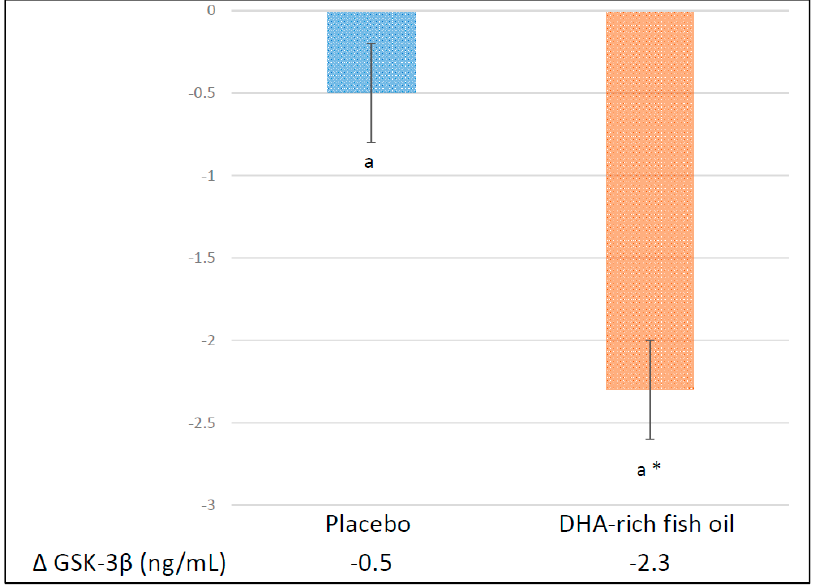
Figure 2. Absolute change in plasma GSK-3 β from baseline to post-intervention in the placebo and the DHA-rich fish oil groups. Data are presented as the mean ± SEM. Significance is set at p < 0.05. * Significant difference in change within group. a A significant difference between the placebo and the DHA-rich fish oil groups. GSK-3 β : glycogen synthase kinase-3 β .